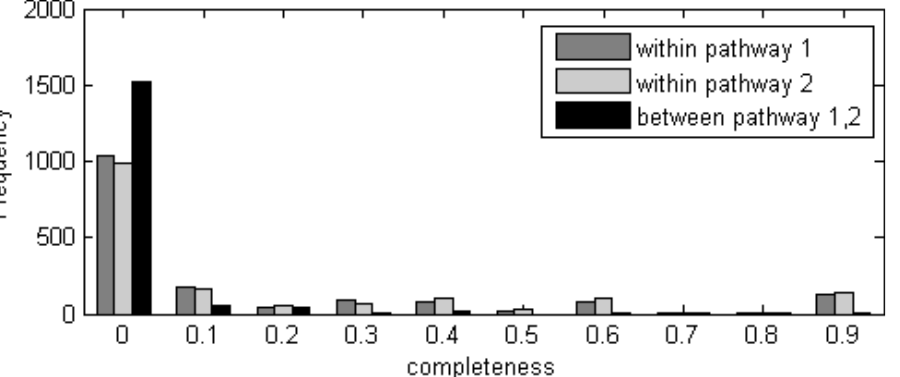
Figure 4. Physical interactions are enriched in pathways we identified and depleted from between-pathway gene pairs.